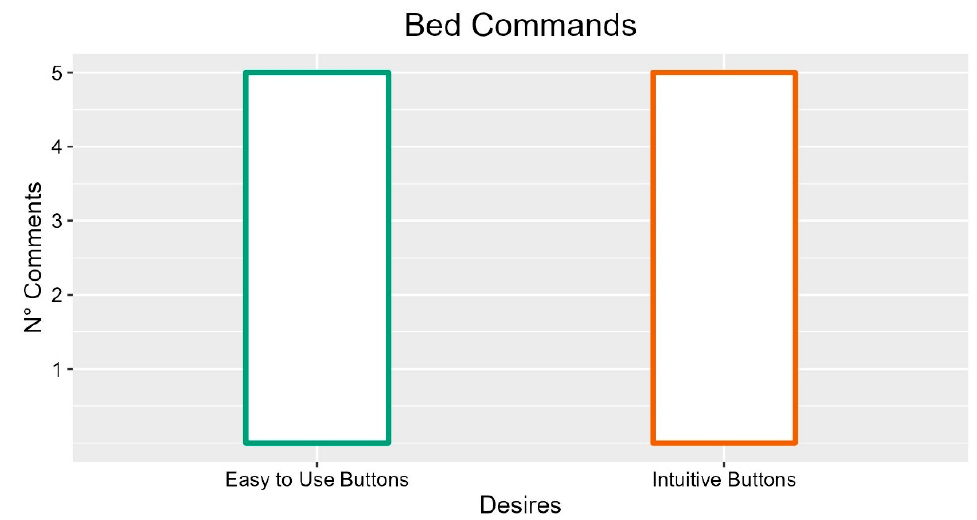
Figure 9. Graphical representation of desires with more occurrences for the Bed Commands theme.